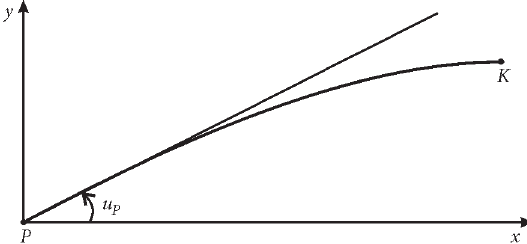
Fig. 2. Transition curves with sloping main tangent in Cartesian coordinate system (Kobryń 2002)